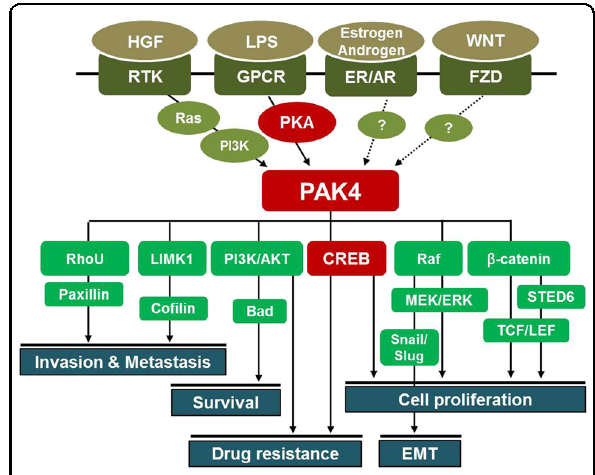
Fig. 3 PAK4-mediated signaling pathways in cancer. PAK4 is activated by various extracellular signals through receptor tyrosine kinases (RTKs), G protein-coupled receptors (GPCRs), ERs, ARs, and WNT-FZD receptors. Activated PAK4 regulates cell proliferation, survival, invasion, metastasis, the epithelial-mesenchymal transition (EMT), and drug resistance in cancers (see the main text for a detailed description). In GPCR and RTK signaling, PKA and Ras, respectively, function upstream of PAK4. The upstream regulators of PAK4 in ER/AR and WNT signaling remain to be determined. HGF hepatocyte growth factor, LPS